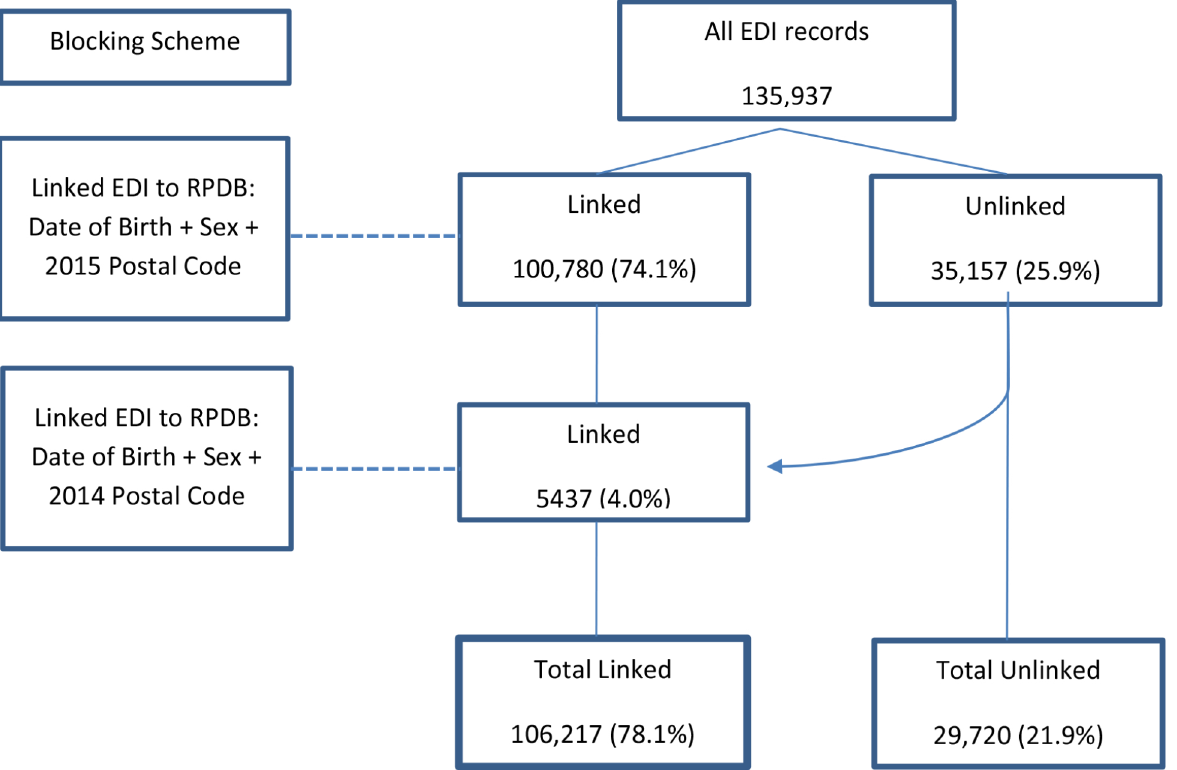
Figure 1: Deterministic linkage process used to link the 2015 Early Development Instrument (EDI) to the Ontario Registered Persons Database